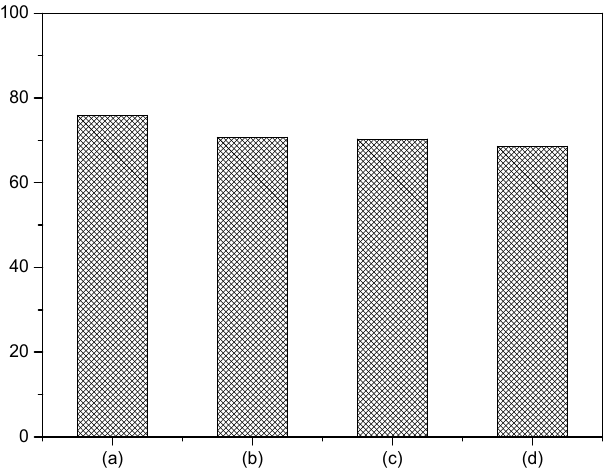
Figure 13. The Evaluation results of target layer.